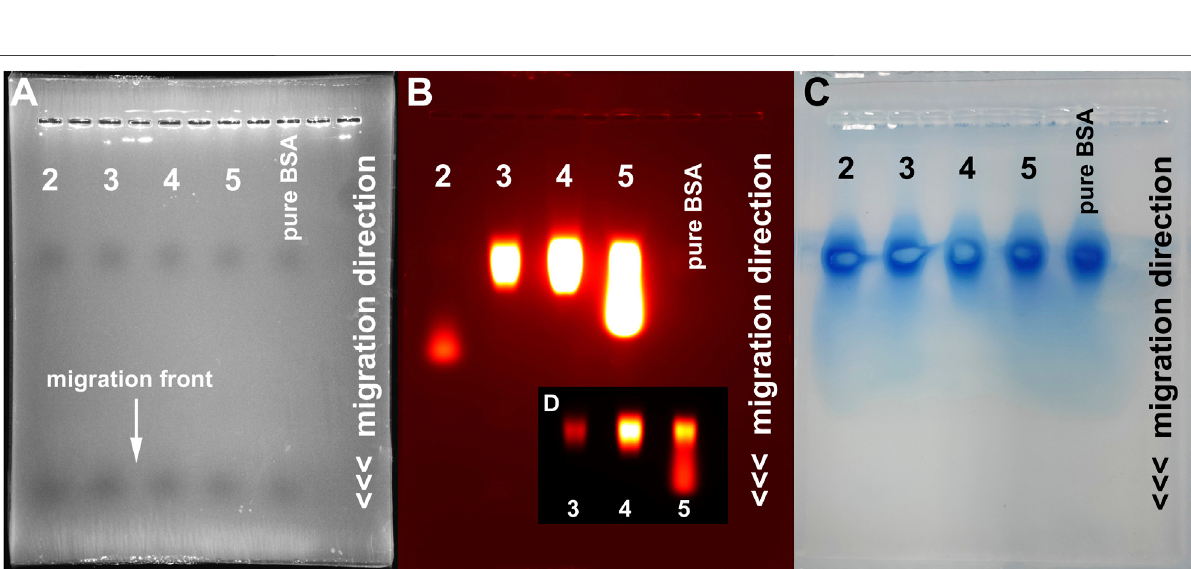
Frontiers in Chemistry |